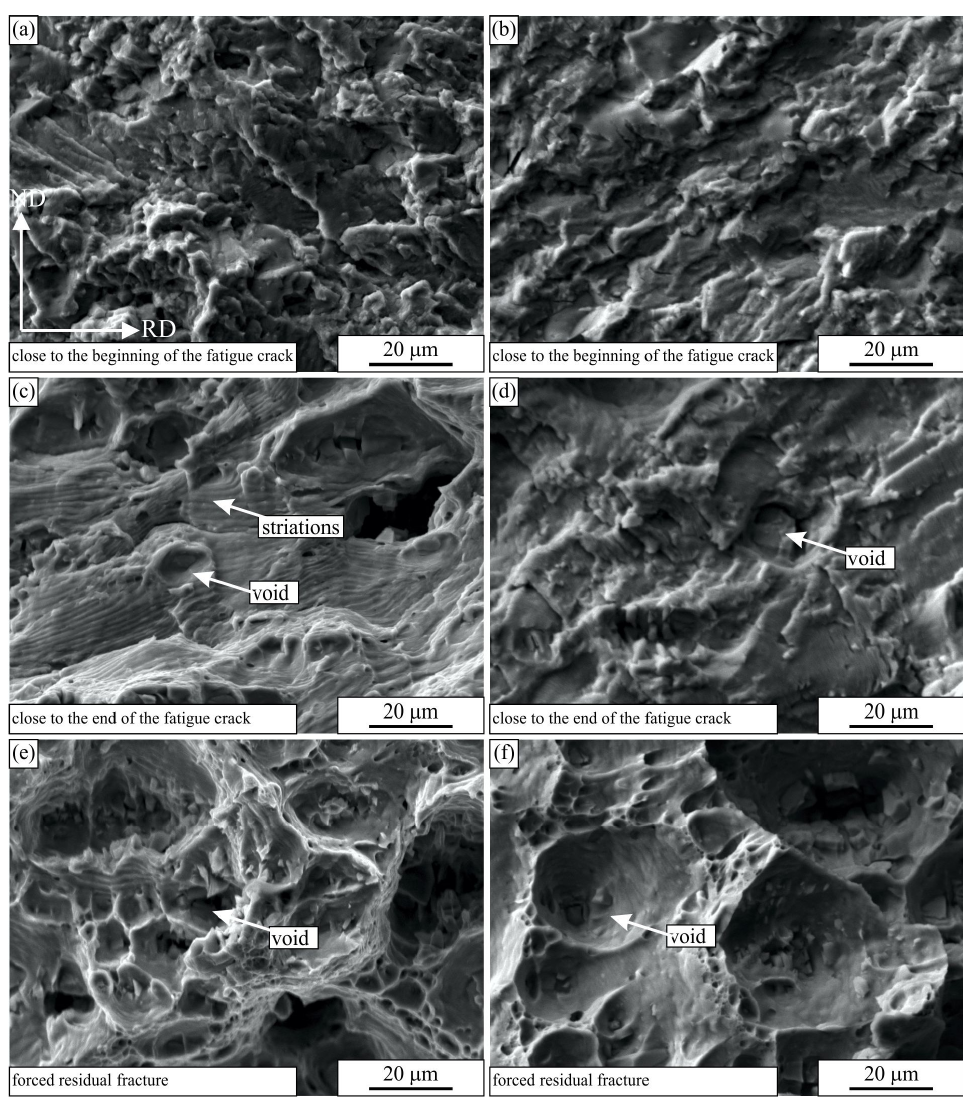
Figure 11. The secondary electron micrographs of the fractured surfaces of the fatigue samples tested in the transverse layout: ( a , c , e ) PSV 18 (135,165 cycles to failure), ( b , d , f ) SV 10 (15,500,000 cycles to failure). The orientation of all images is the same. The TD direction is perpendicular to the images.